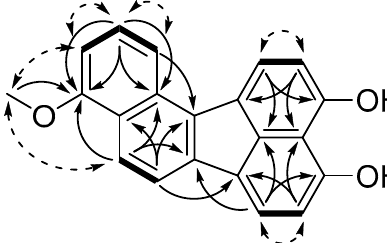
Figure 2. Key nuclear magnetic resonance (NMR) correlations of viridistratin B ( 2 ). Bold bonds: 1 H / 1 H correlation spectroscopy (COSY) correlations, plain arrows: 1 H / 13 C (heteronuclear multiple bond correlation (HMBC) correlations and dashed arrows: rotating frame nuclear Overhauser effect spectroscopy (ROESY) correlations.